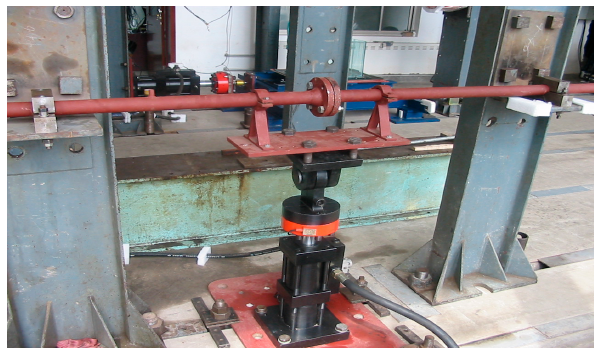
Figure 7. Arrangement of the laboratory test, which simulated the characteristics of the actual